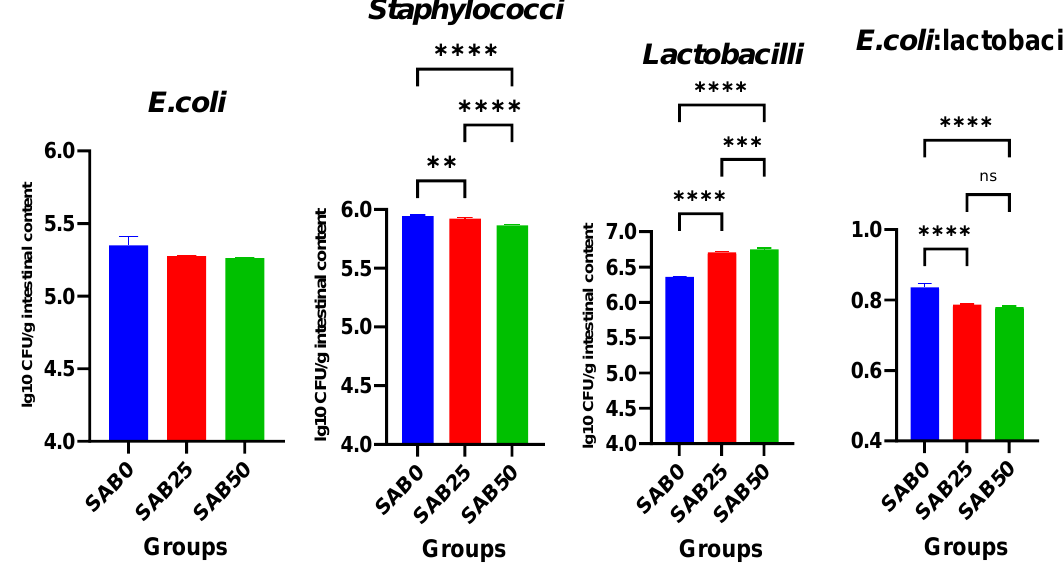
Figure 2. Effects of dietary salicin standardized extract from SAB on intestinal microflora in broiler chickens . Bars represent means ± SEM. Abbreviations: SAB0 — basal diet, without SAB; SAB25 — basal diet + 25 g SAB /100 g diet; SAB50 — basal diet + 50 g SAB /100 g diet; ** p < 0.01; *** p < 0.001; **** p < 0.0001